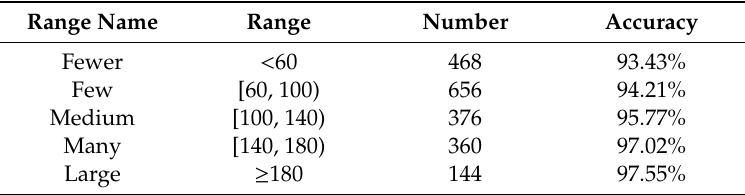
Table 2. Counting results of different numerical ranges.